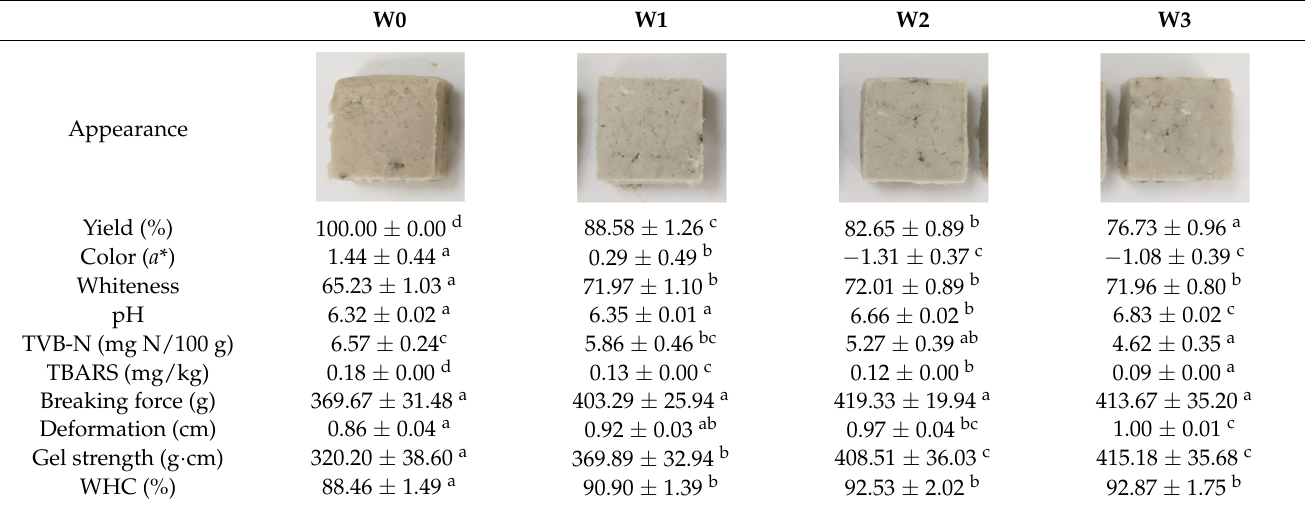
Table 3. Physicochemical characteristics of surimi with different washing times.